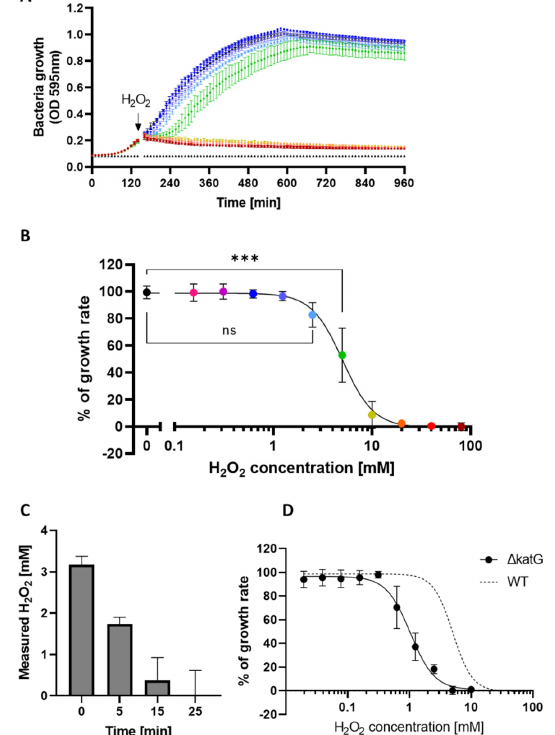
Figure 1. Effect of H 2 O 2 on E. coli BW25113. ( A ) Bacterial growth of E. coli BW25113 exposed to increasing concentrations of H 2 O 2 , added during the exponential phase (OD 595nm = 0.2). The color code corresponds to the different H 2 O 2 concentrations depicted in the graph in ( B ); (means of technical duplicate +/ − SD; one representative experiment); ( B ) Representation of the growth rate (% of the control condition) as a function of H 2 O 2 concentrations. The sublethal concentration was defined as the highest concentration where the growth rate was not significantly different from the control condition, namely 2.5 mM; (mean +/ − SD; N = 3; statistical test was ANOVA with Turkey multiple comparison; *** p ≤ 0.001); ( C ) Quantification of H 2 O 2 degradation using Amplex Red/HRP after addition of 2.5 mM H 2 O 2 to bacterial culture at OD 595nm = 0.2 (mean +/ − SD; N = 3); ( D ) Growth rate (% of the control condition) of the katG deleted mutant as a function of the H 2 O 2 concentration, WT from panel B shown as dotted line (mean +/ − SD, N =